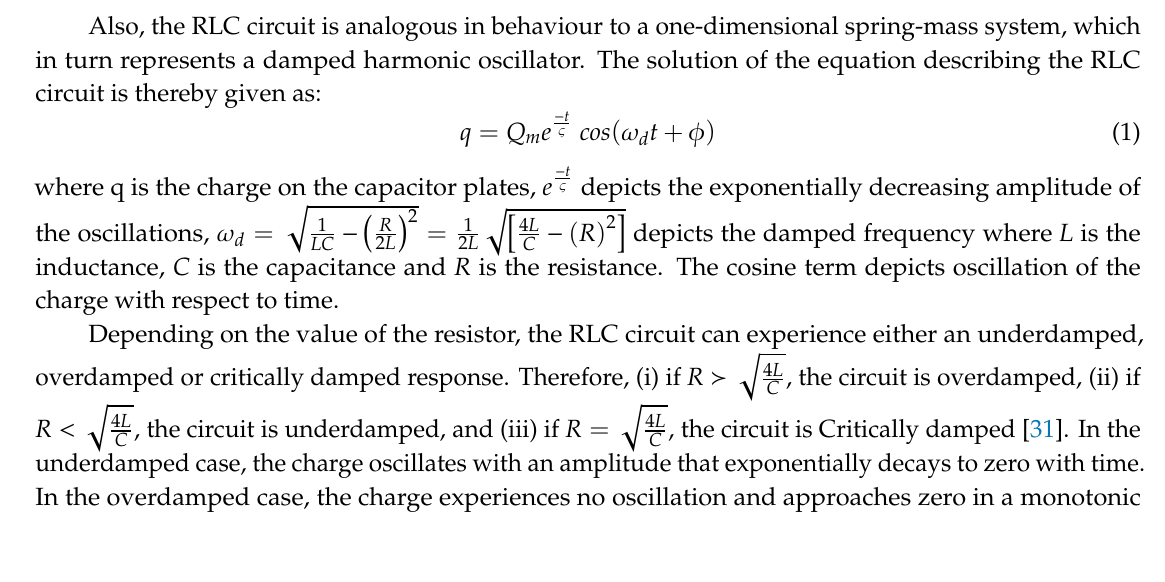
Figure 1. A series RLC circuit with an AC source, where R1 is a resistor, C1 is a capacitor and L1 is an inductor.